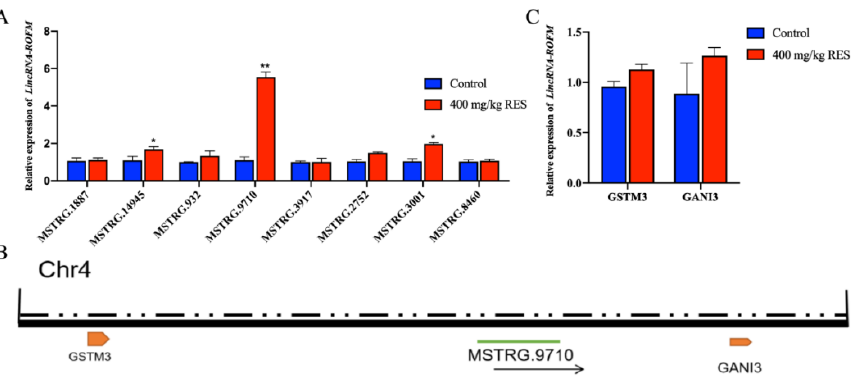
Figure 1. Identification of LincRNA-ROFM as a candidate lncRNA. ( A ) mRNA expression levels of candidate lncRNAs in porcine subcutaneous fat in control and 400 mg/kg RES groups as detected by RT-qPCR assay. ( B ) The map of lncRNA-MSTRG.9710 genome location model. Chr4, chromosome 4. ( C ) mRNA expression levels of GSTM3 and GNAI3 in control and 400 mg/kg RES groups as detected by RT-qPCR assay. Data are presented as the mean ± SEM (n = 3) vs. control, * p < 0.05, ** p < 0.01.